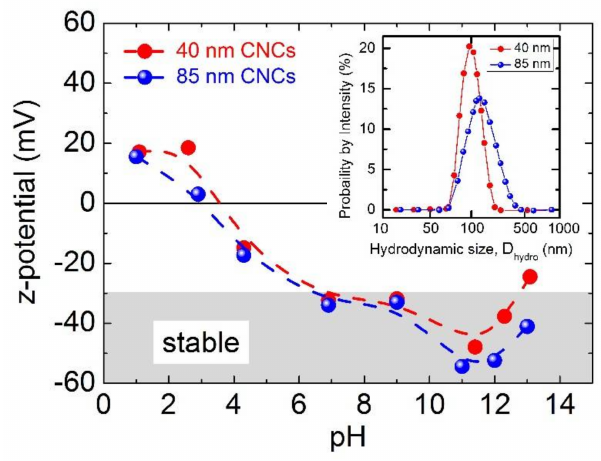
Figure 4. Effect of pH on the z-potential of 40-nm and 85-nm nanoclusters (CNCs). The shaded area indicates the region of colloidal stability. Inset: mean hydrodynamic diameters obtained by dynamic light scattering (DLS), weighted by intensity for the as-made purified samples, namely, D hydro ∼ = 93 nm (PdI ∼ = 0.055) and D hydro ∼ = 125 nm (PdI ∼ = 0.181), respectively (PdI = polydispersity